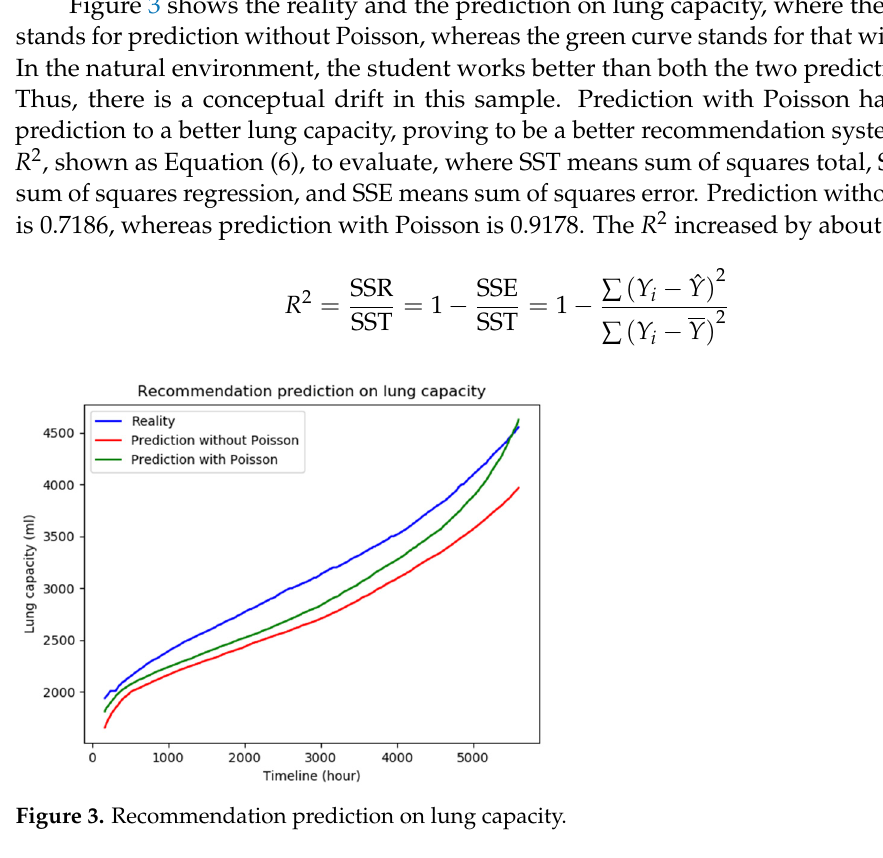
Figure 4. Recommendation prediction on long-distance running. The values below 0 mean that students did not run or were not scheduled to run at that day. Additionally, in that case, the more days the college student rested, the longer the days that the system would set for continuous running without the double-train feedback mechanism, which does not meet the requirements of physical exercise. The recommendation system with the mechanism would not schedule to run for more than five days continuously, even if it detects laziness on the part of the student, which is reasonable. Moreover, when we look at the recommendation system with the double-chain feedback mechanism, we can easily find that the recommended work and rest time is regular (the college student would not be scheduled to run continuously for a long time